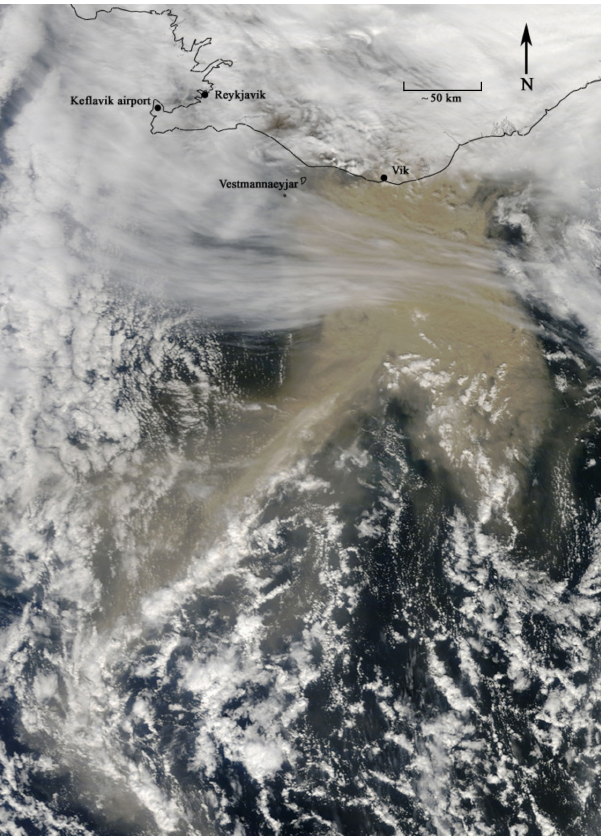
Figure 9. MODIS true-colour image showing the low-level ash cloud coming off Iceland and spreading southwards. Notice that meteorological cloud is clearly evident above the ash layer and is either obscuring the ash layer over Iceland or the ash layer ends near the coast. Grímsvötn is just off the image to the north. (Image: MODIS/Terra, 23 May 2011,